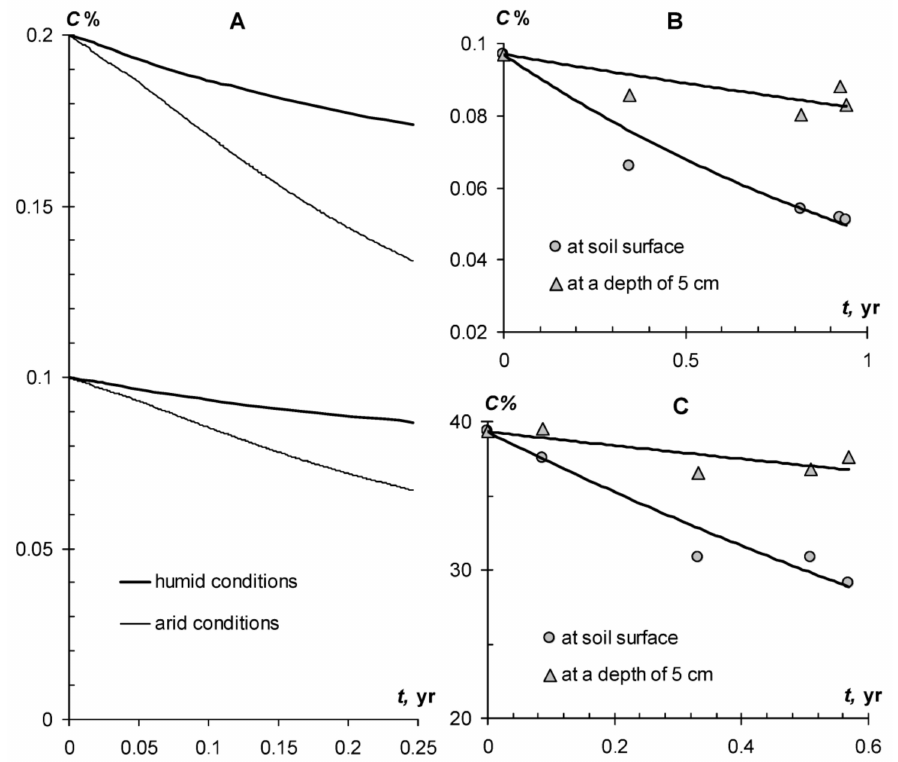
Figure 5. Modeling and experimental evaluation of biodegradation of organic soil-modifiers under different conditions. ( A ) modeling of biodegradation of SSHP (doses 0.1 and 0.2%) depending on temperature in humid and arid climates. ( B ) biodegradation of hydrogel, ( C ) biodegradation of peat soil modifier in experimental soil constructions for urban lawns (Moscow). The equations of exponential regression as an analytical solution of (1): ( B ) (at soil surface): C % = 0.1 · exp( − 0.712 · t ), R 2 = 0.93; ( B ) (at depth of 5 cm): C % = 0.1 · exp( − 0.171 · t ), R 2 = 0.69; ( C ) (at soil surface): C % = 39.3 · exp( − 0.543 · t ), R 2 = 0.93. ( C ) (at depth of 5 cm): C % = 39.3 · exp( − 0.118 · t ), R 2 =